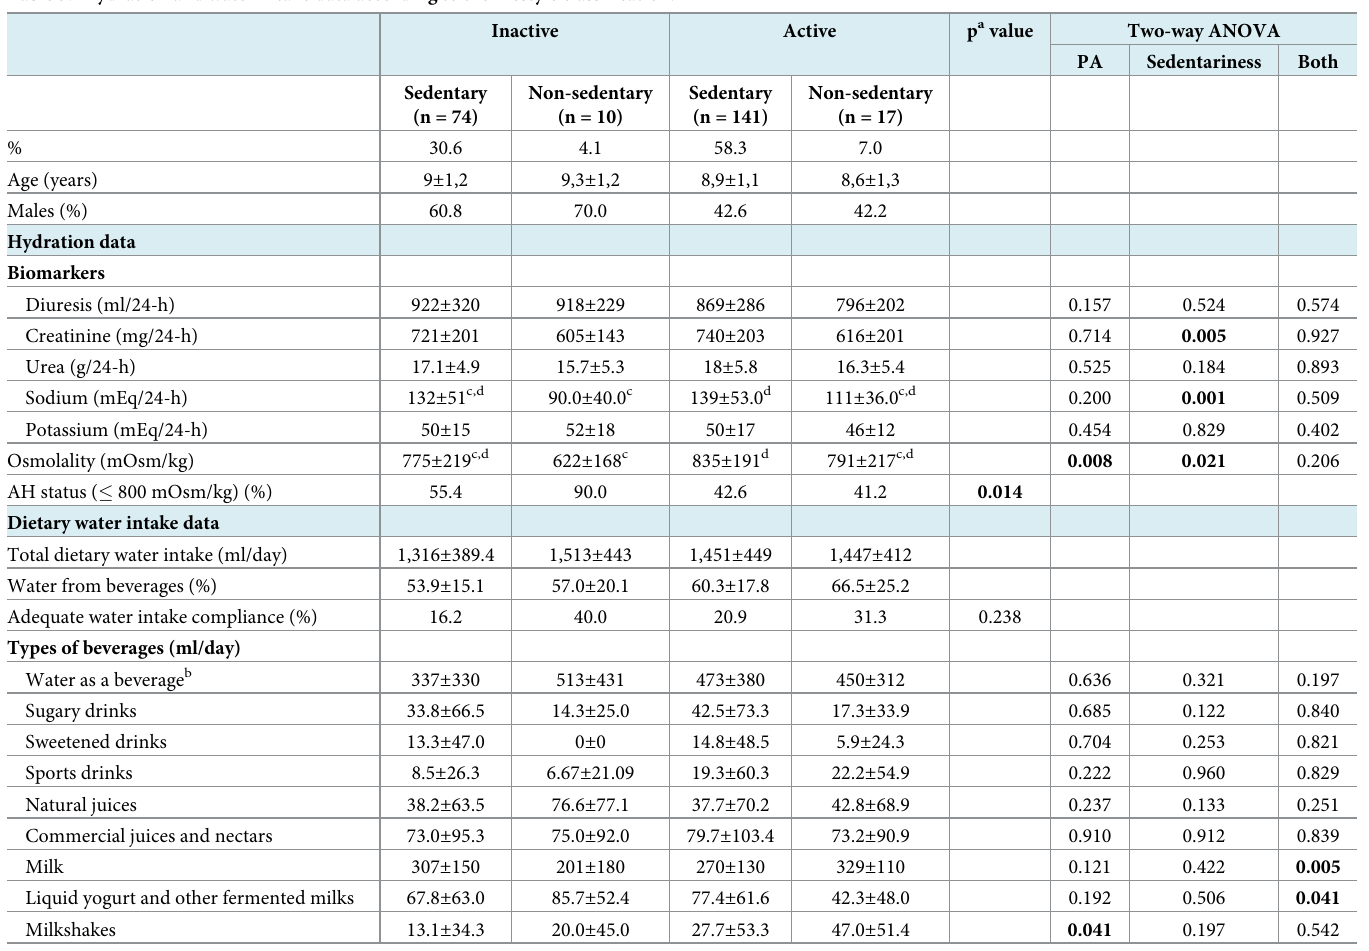
Table 3. Hydration and water intake data according to the lifestyle